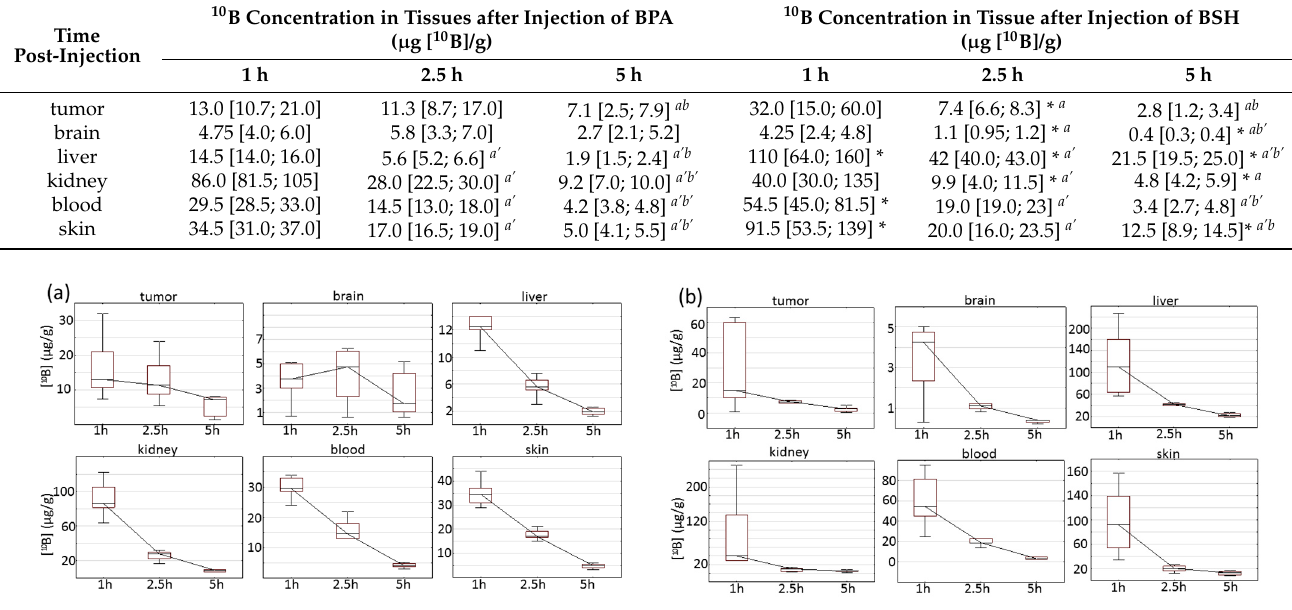
Figure 2. Box plots of absolute concentration of boron in different tissues at 1, 2.5 and 5 h after injection of BPA ( a ) and BSH ( b ). Box borders indicate 25th and 75th percentiles (interquartile range); lines within boxes indicate the median.